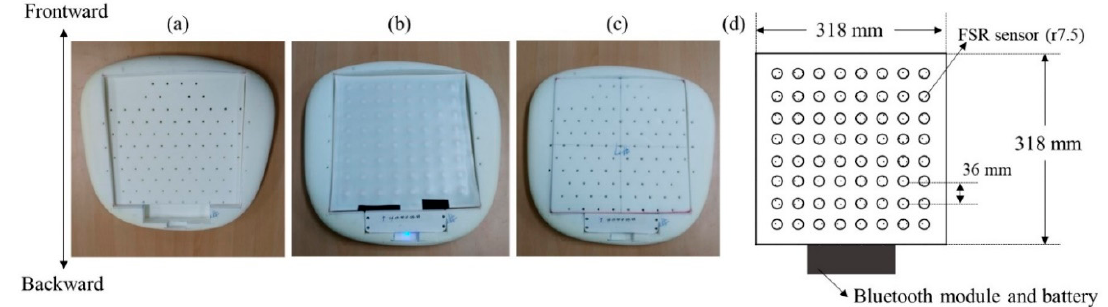
Figure 6. Designed chair cushion with pressure sensor for experiment. ( a ) The space inside the existing cushion has sufficient space for accommodating the sensor; ( b ) A film-type 8 × 8 sensor and a circuit for data processing were inserted into the cushion; ( c ) The upper part of the sensor was supplemented with a cut cushion; ( d ) The illustrated image of the pressure sensor mat with its detailed dimensions.